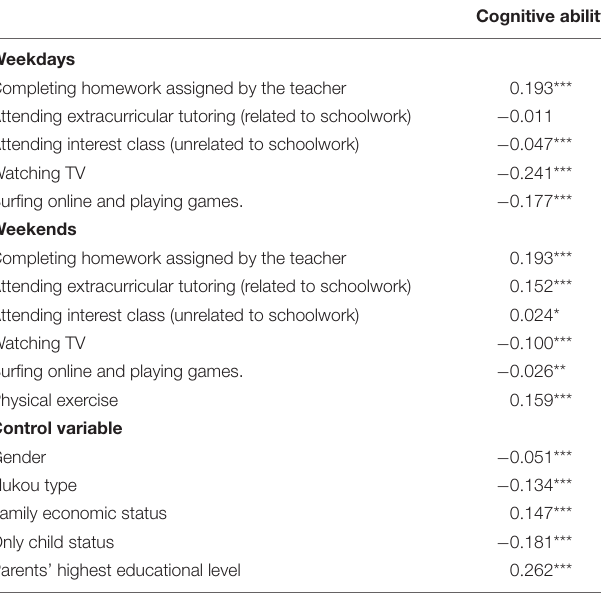
TABLE 2 | Correlation between extracurricular activities and cognitive